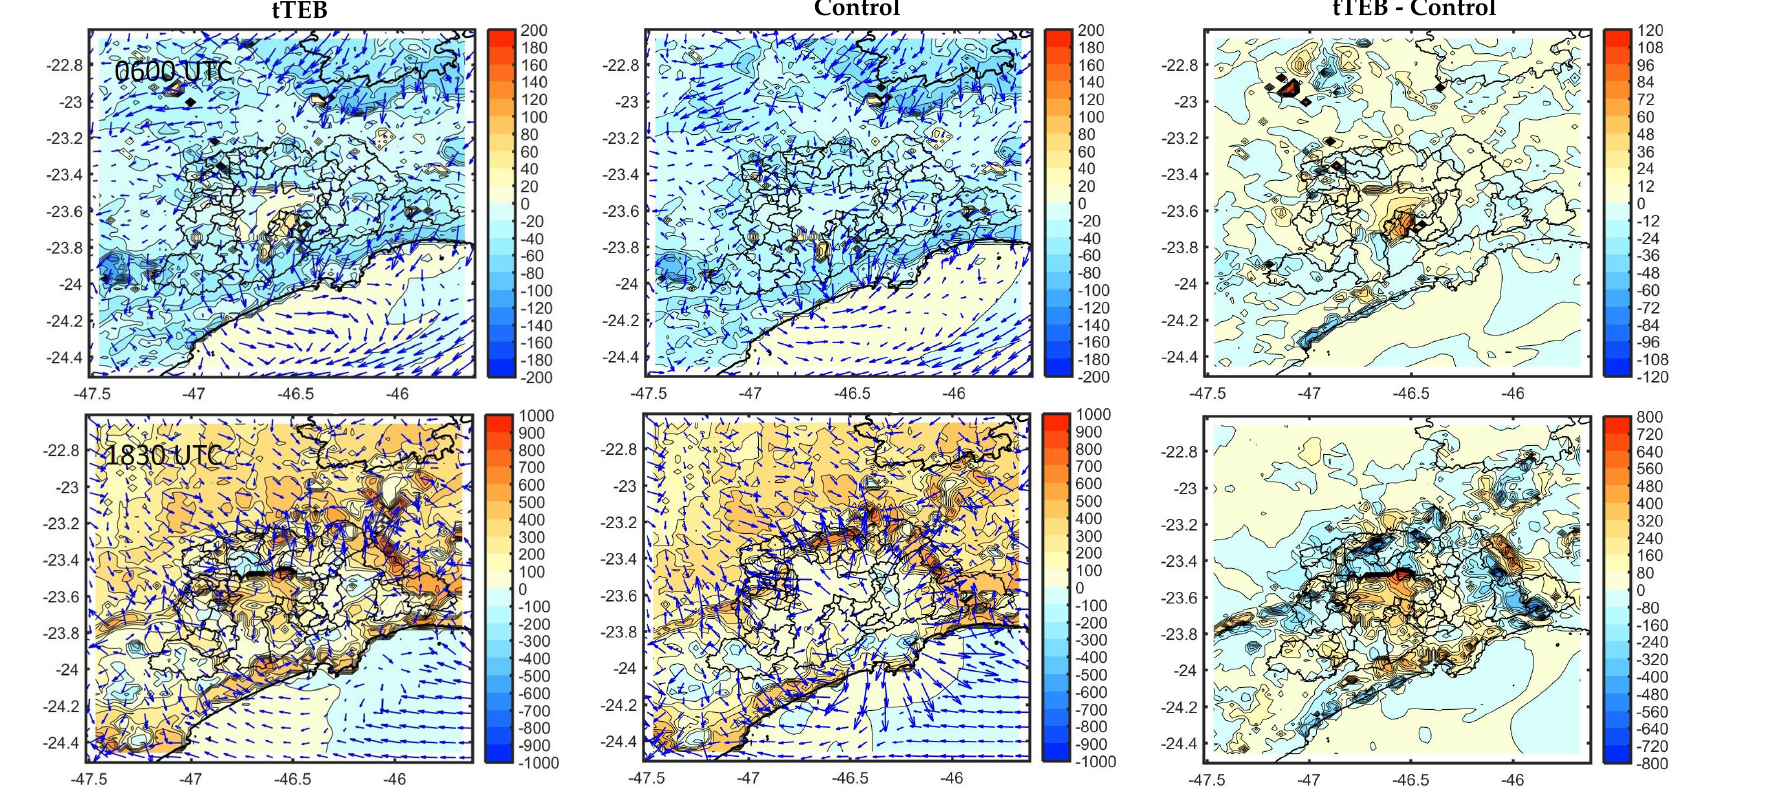
Figure 13. Horizontal pattern of sensible heat flux (W m − 2 ) at the surface for 12 January 2015 at 06 UTC (03 LT) (first row) and 1830 UTC (1530 LT) (second row). The figure shows the results of the tTEB experiment (first column), control experiment (second column) and the differences between both experiments (third